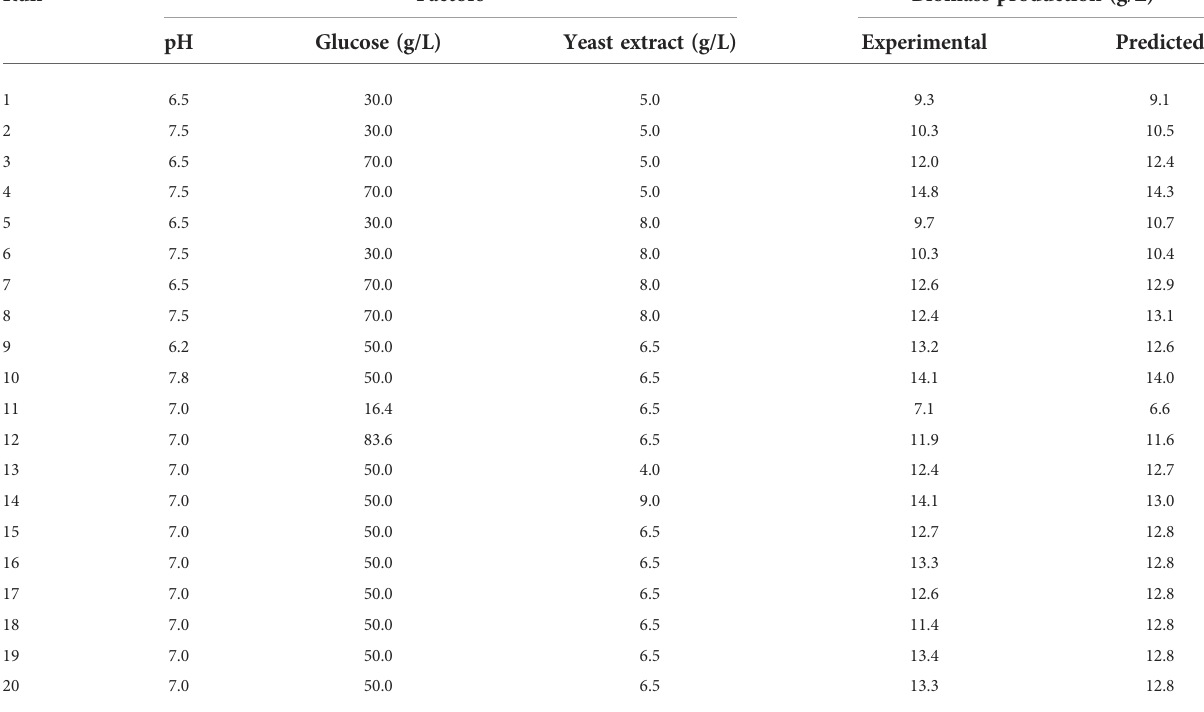
TABLE 1 Optimization of initial pH, initial glucose and yeast extract concentrations using RSM with CCD. Run Factors pH Glucose (g/L) Yeast extract